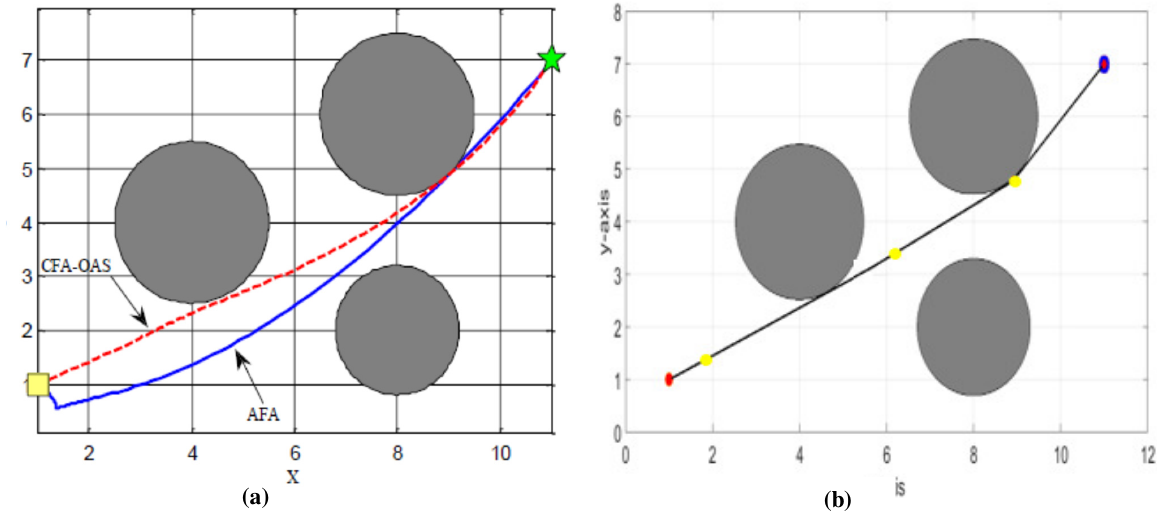
Fig. (18, (a)-(b)). The Best Results Achieved by (a) Reference [16], and (b) GWO.